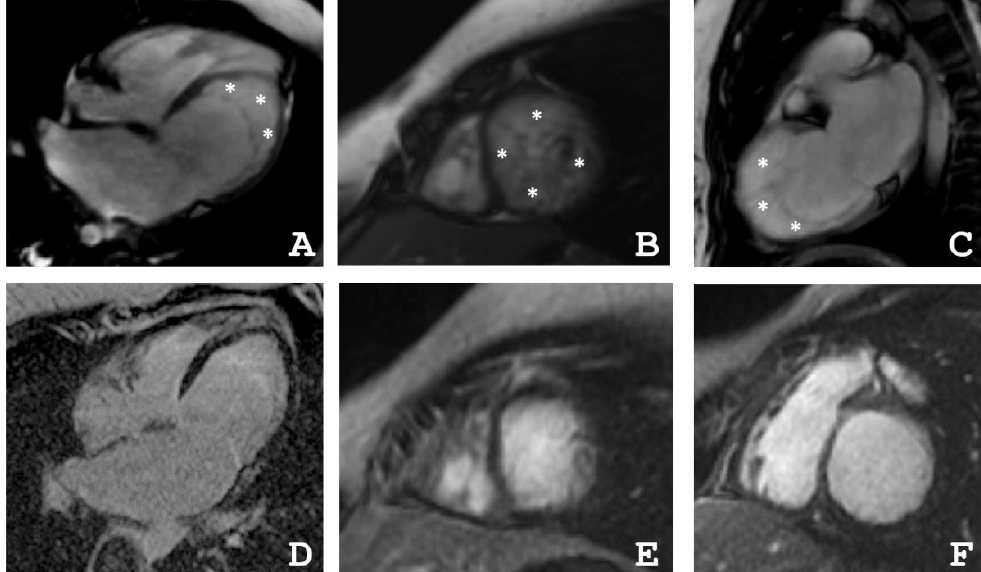
Figure 3. ( A – C ) Proband’s daughter (IV-3) cardiac magnetic resonance imaging in movie mode, SSFP sequence: ( A ) long axis 4–chamber projection, ( B ) short axis at the level of the apical segments, ( C ) long axis 2–chamber projection, * indicates the layer of non-compact myocardium, ( D , F ) delayed contrast. Inversion recovery sequence with suppression of the signal from the myocardium: ( D ) long axis 4–chamber projection, ( E ) short axis at the level of apical segments, ( F ) short axis at the level of basal segments. There were no areas of contrast, which indicates the absence of areas of intramyocardial fibrosis, scarring, and inflammatory myocardial damage.